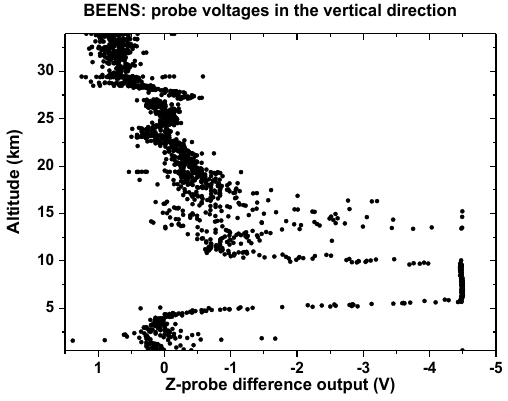
Figure 10. Difference output from the z probes (P 5 –P 1 pair).